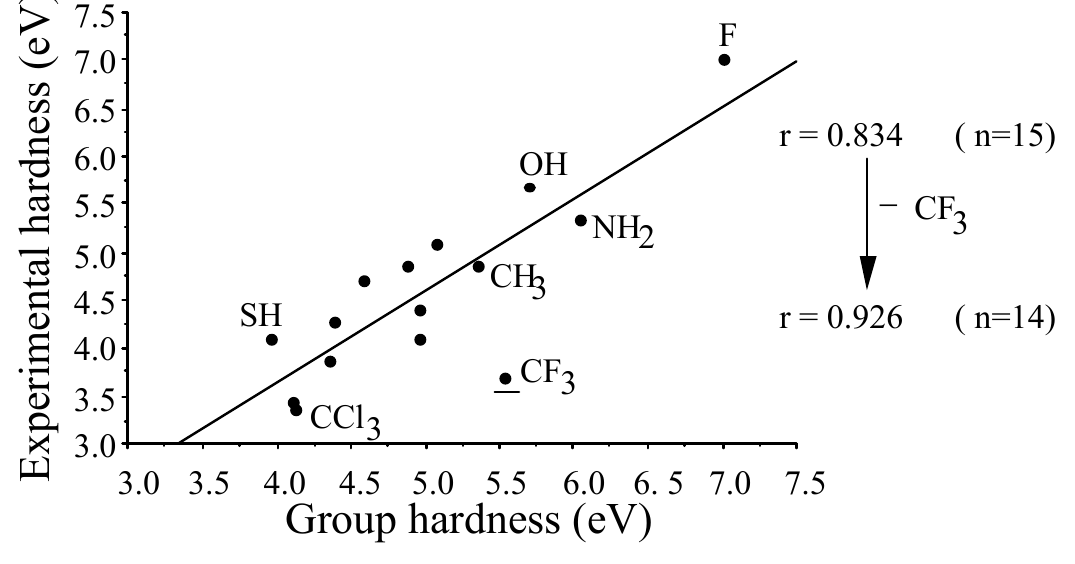
Figure 8 : Calculated vs. Experimental Group Hardness values (see